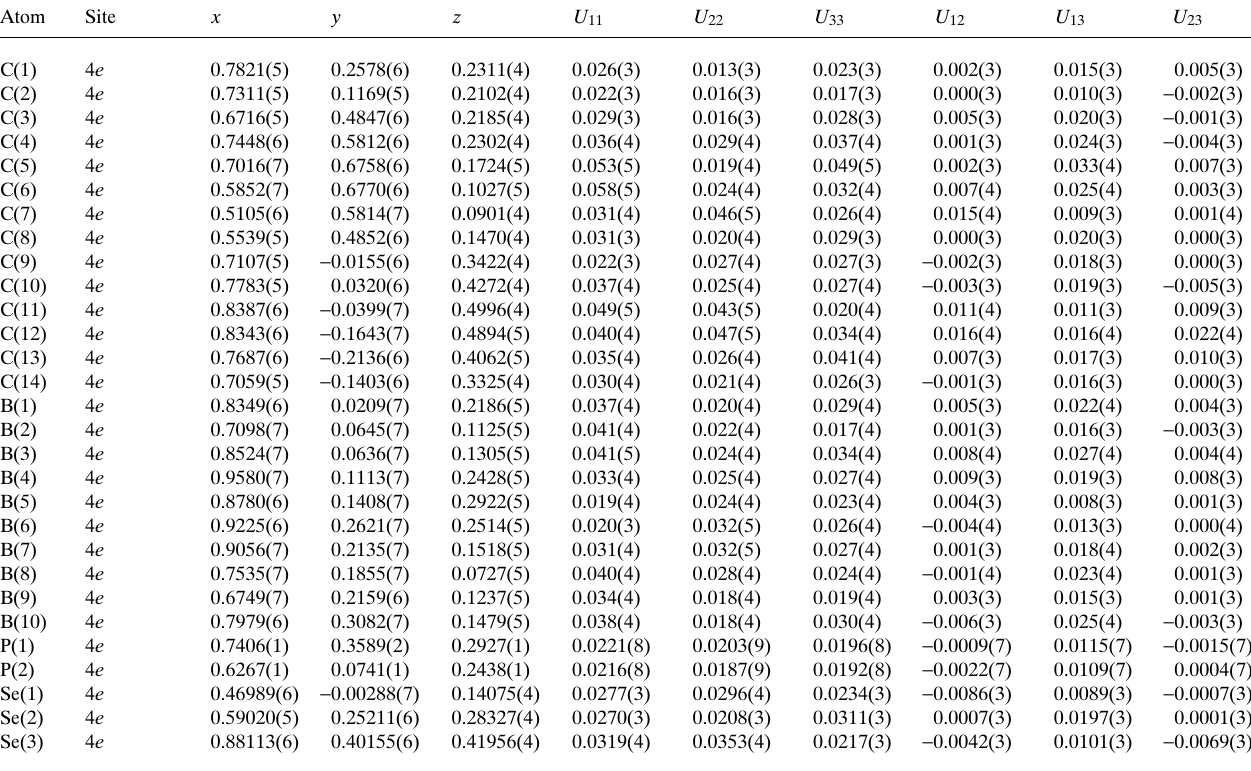
Table 3. Atomic coordinates and displacement parameters (in Å 2 )